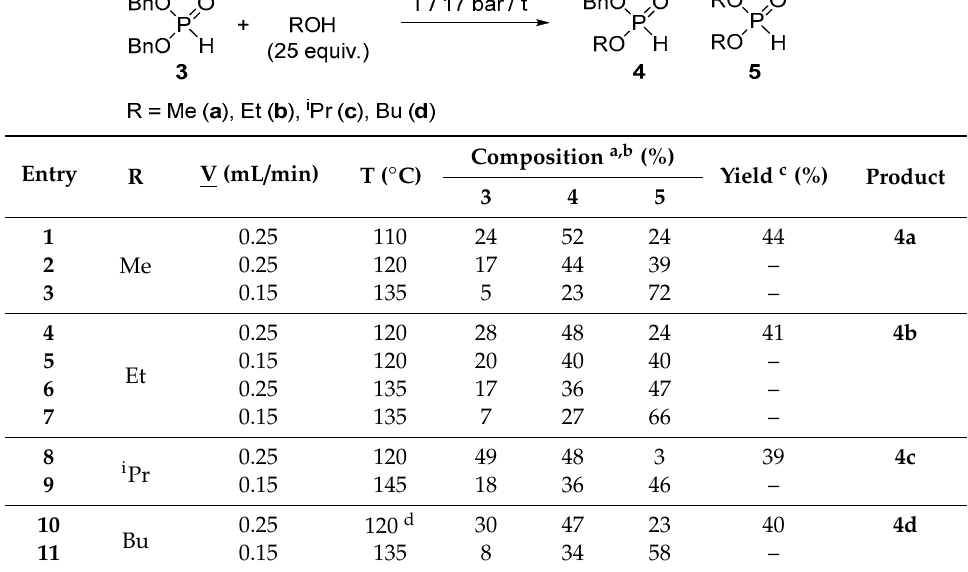
Table 7. Continuous flow MW-assisted alcoholysis of dibenzyl phosphite.